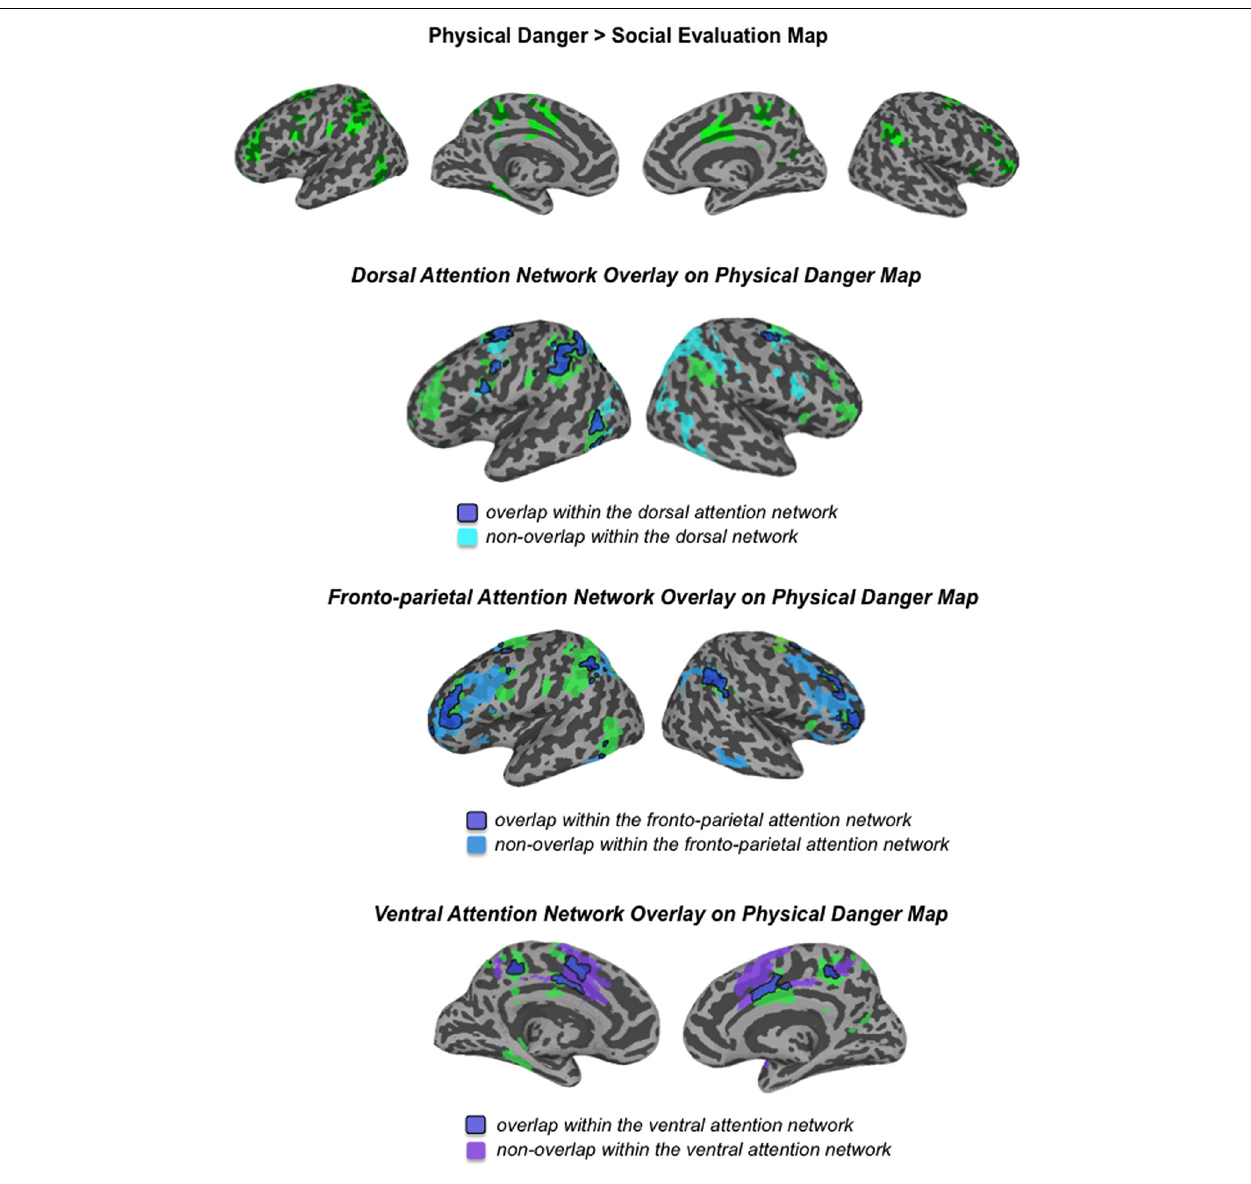
FIGURE 5 | Comparison of the physical danger map from this study with the attention networks defined byYeo etal.